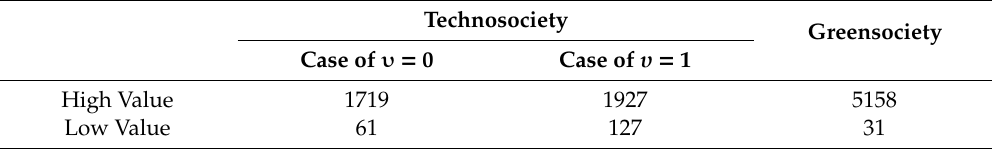
Table 5. Cost estimates from the model: deterministic case (USD